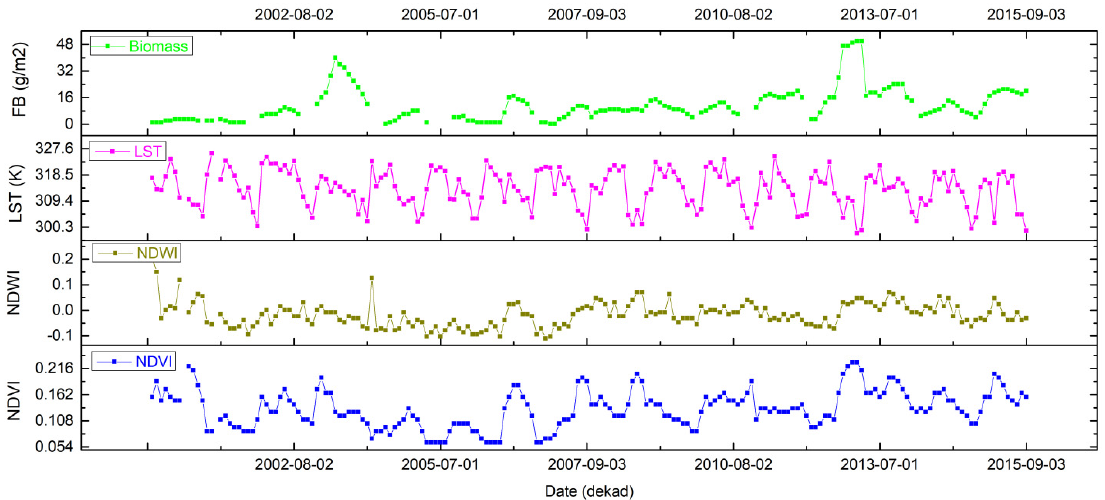
Figure 12). Higher-resolution remote sensing and soil moisture data are of great signifi- cance for drought monitoring in arid DS regions. This will be the purpose and focus of our future research.